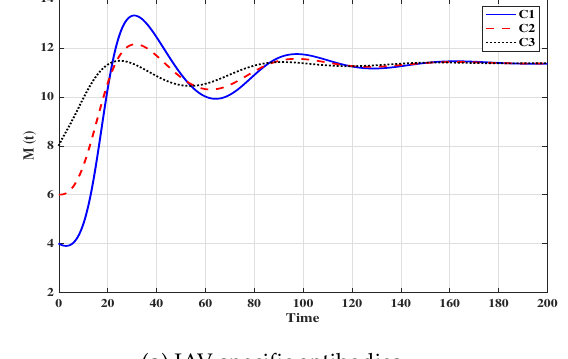
Figure 6. Solutions of system (3) with initials C1–C3 tend to Ξ 4 = ( 5.56,0,1.11,0,0.8,0,11.39 )